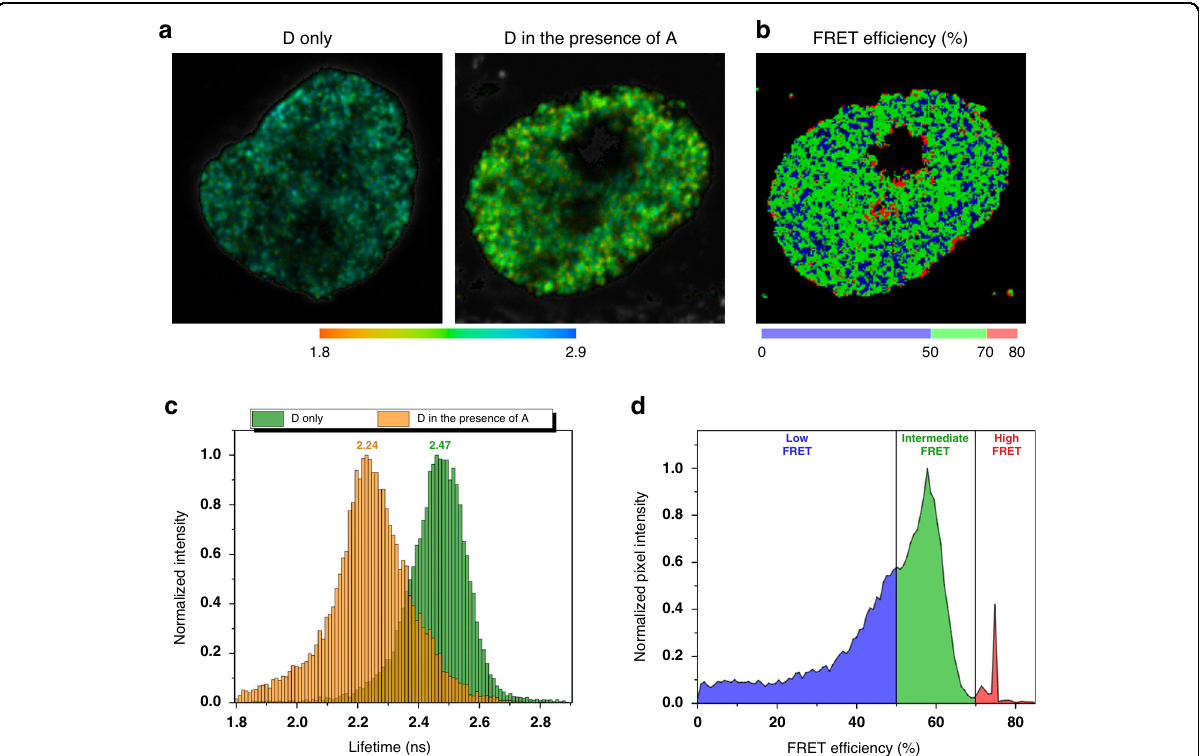
Fig. 4 FLIM-FRET mapping of genomic DNA compaction in HeLa cell nucleus. The replicating cells were labeled in early and mid S-phase with AlexaFluor 546 (donor) and AlexaFluor 647 (acceptor) fl uorophores correspondingly. a Representative images of AlexaFluor 546 lifetime distribution in the nucleus in the absence and in the presence of AlexaFluor 647. In the presence of acceptor, the fl uorescence lifetime of the donor is shortened due to FRET ( b ). The FRET ef fi ciency distribution in the cell nucleus calculated according to donor fl uorophore lifetime distribution. Colormap was empirically de fi ned from the FRET distribution histogram (shown on ( d )). c Representative histograms of the donor lifetimes in the absence and in the presence of the acceptor. d FRET distributions histogram showing three populations (low, intermediate and high FRET), designated by corresponding colors. See Fig. S6 for additional